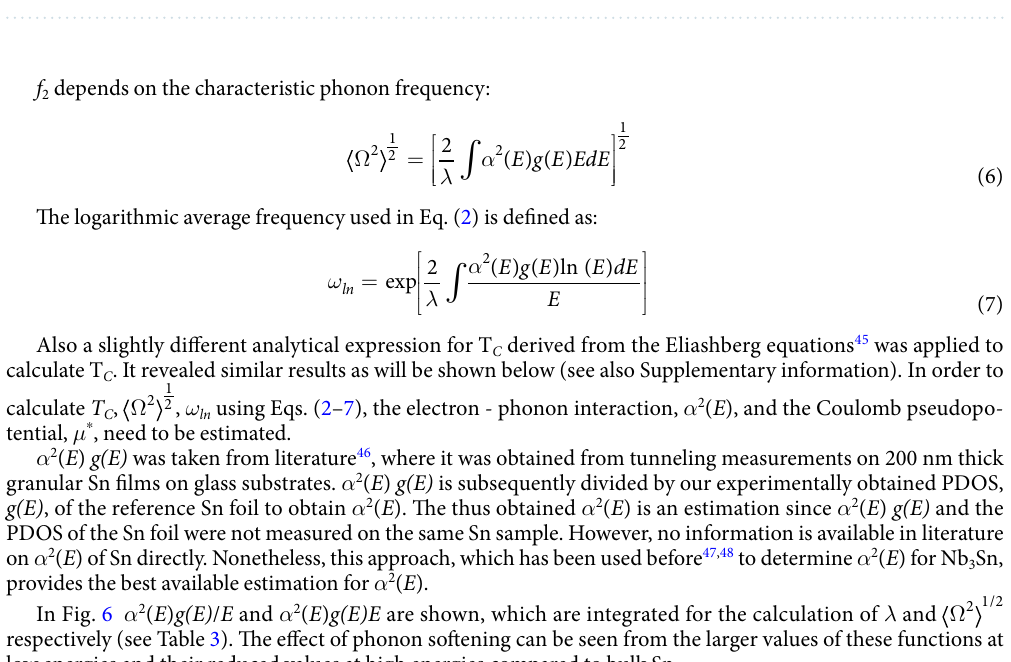
Figure 6. ( a ) The phonon density of states was combined with α 2 ( E ) to obtain α 2 ( E ) g(E) / E for the Sn cluster- assembled film and the island samples in comparison to bulk Sn. ( b ) The phonon density of states was combined with α 2 ( E ) and replotted as α 2 ( E ) g(E)E for the different Sn nanostructures and the 119 Sn reference